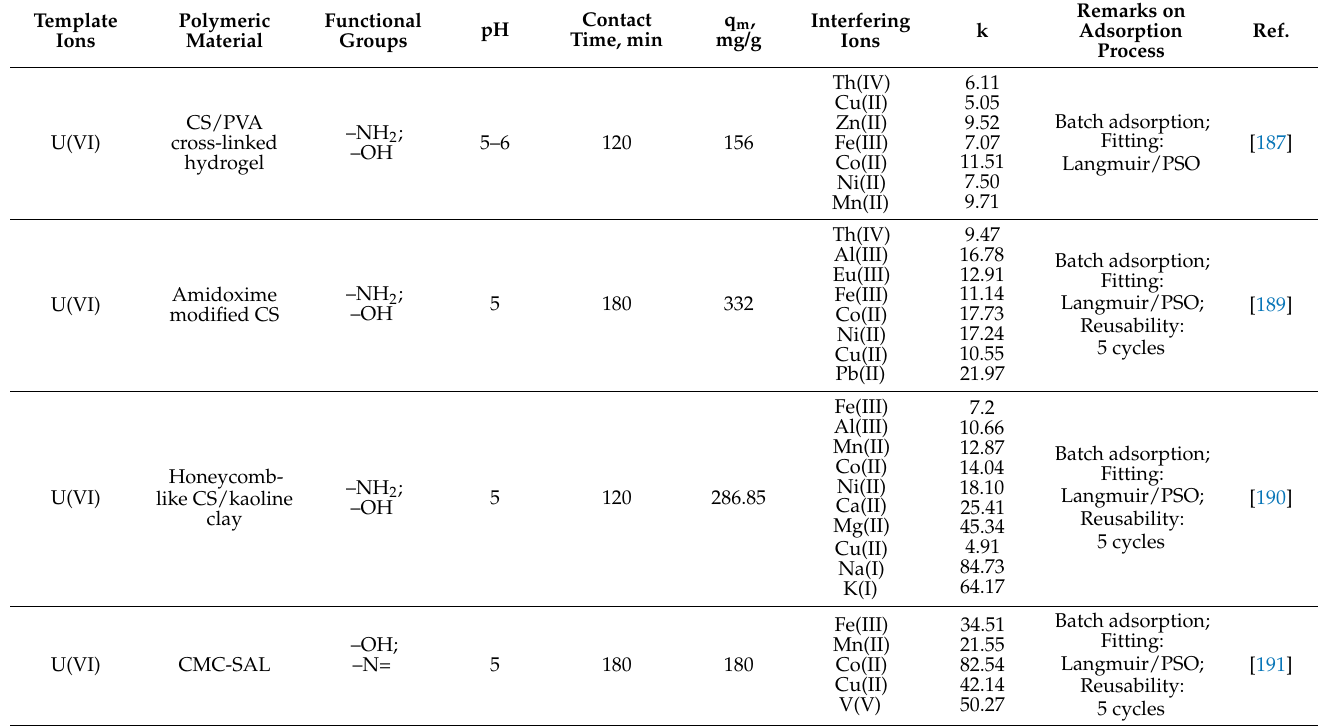
Table 5. Selective extraction of radionuclides and rare earth metal